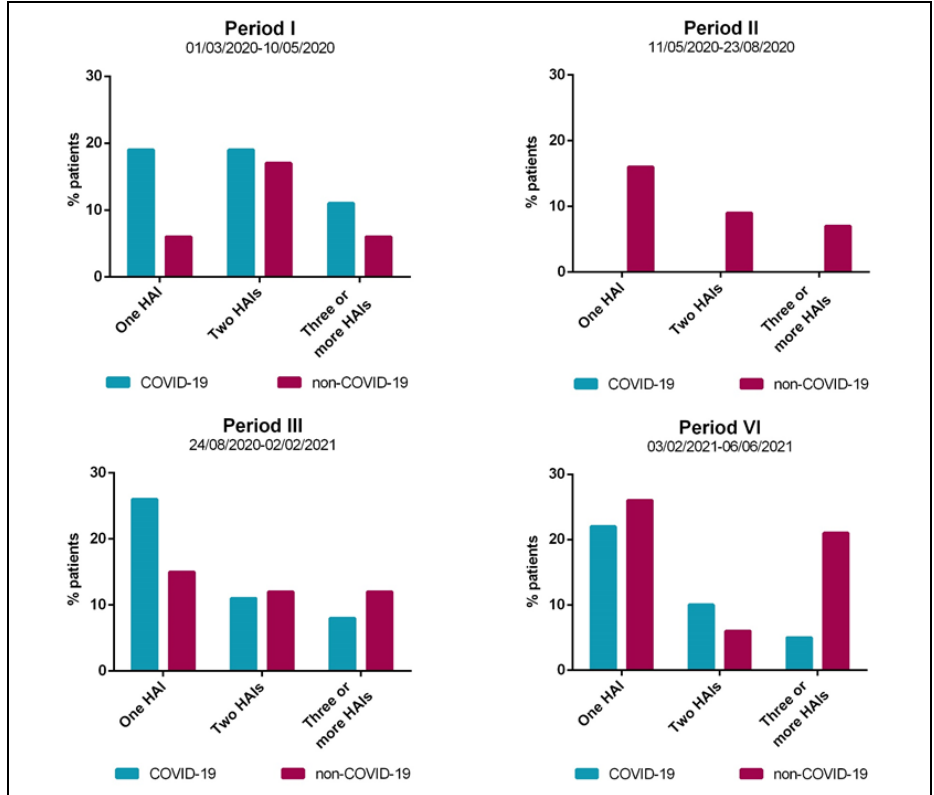
Figure 1. Cumulative incidence of patients with at least one healthcare-associated infection